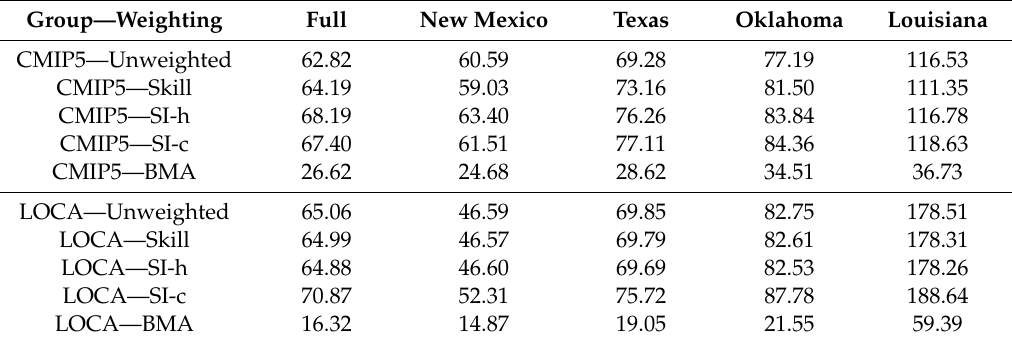
Table 2. Standard Deviation (mm) of Ensemble Mean Projected Change—Unweighted CMIP5 and LOCA ensembles vs. weighted CMIP5 and LOCA ensembles for the full domain and all subdomains.